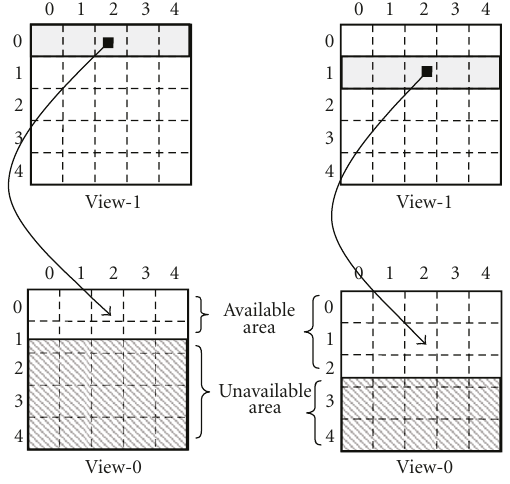
Figure 8: Systematic restriction of reference